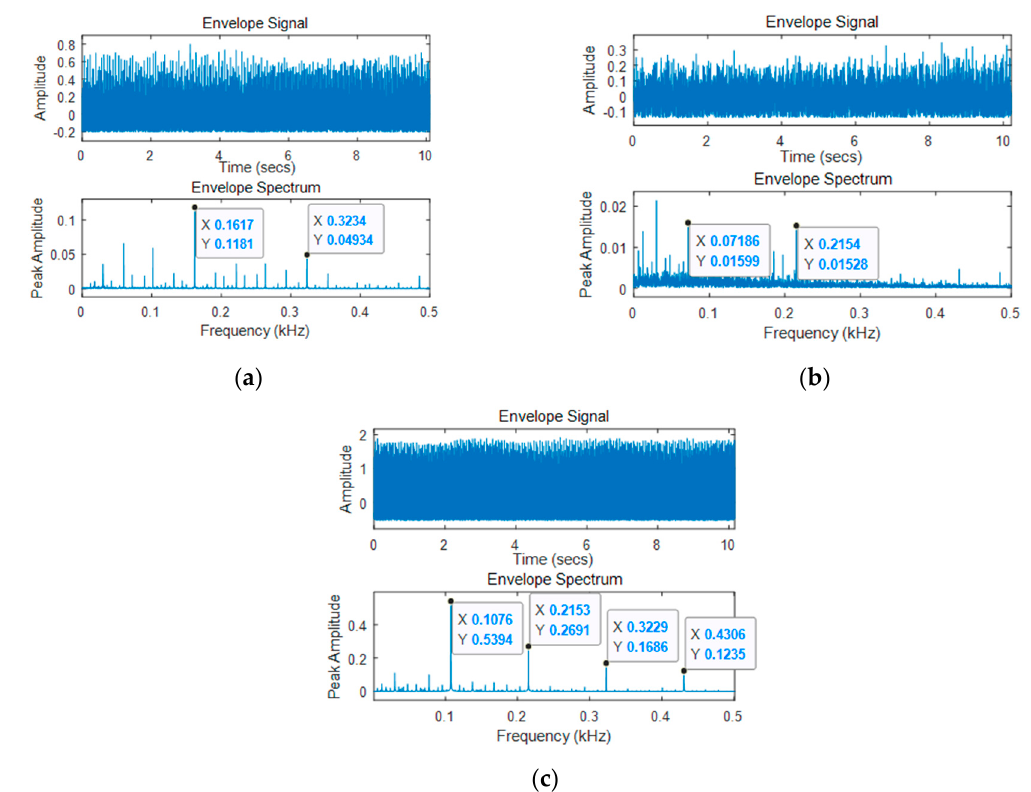
Figure 5. Envelope signal and corresponding envelope spectrum of raw signals at 1797rpm with respect to ( a ) IR fault, ( b ) OR fault, and ( c ) RE fault. Table 2. Bearing details and fault frequencies.